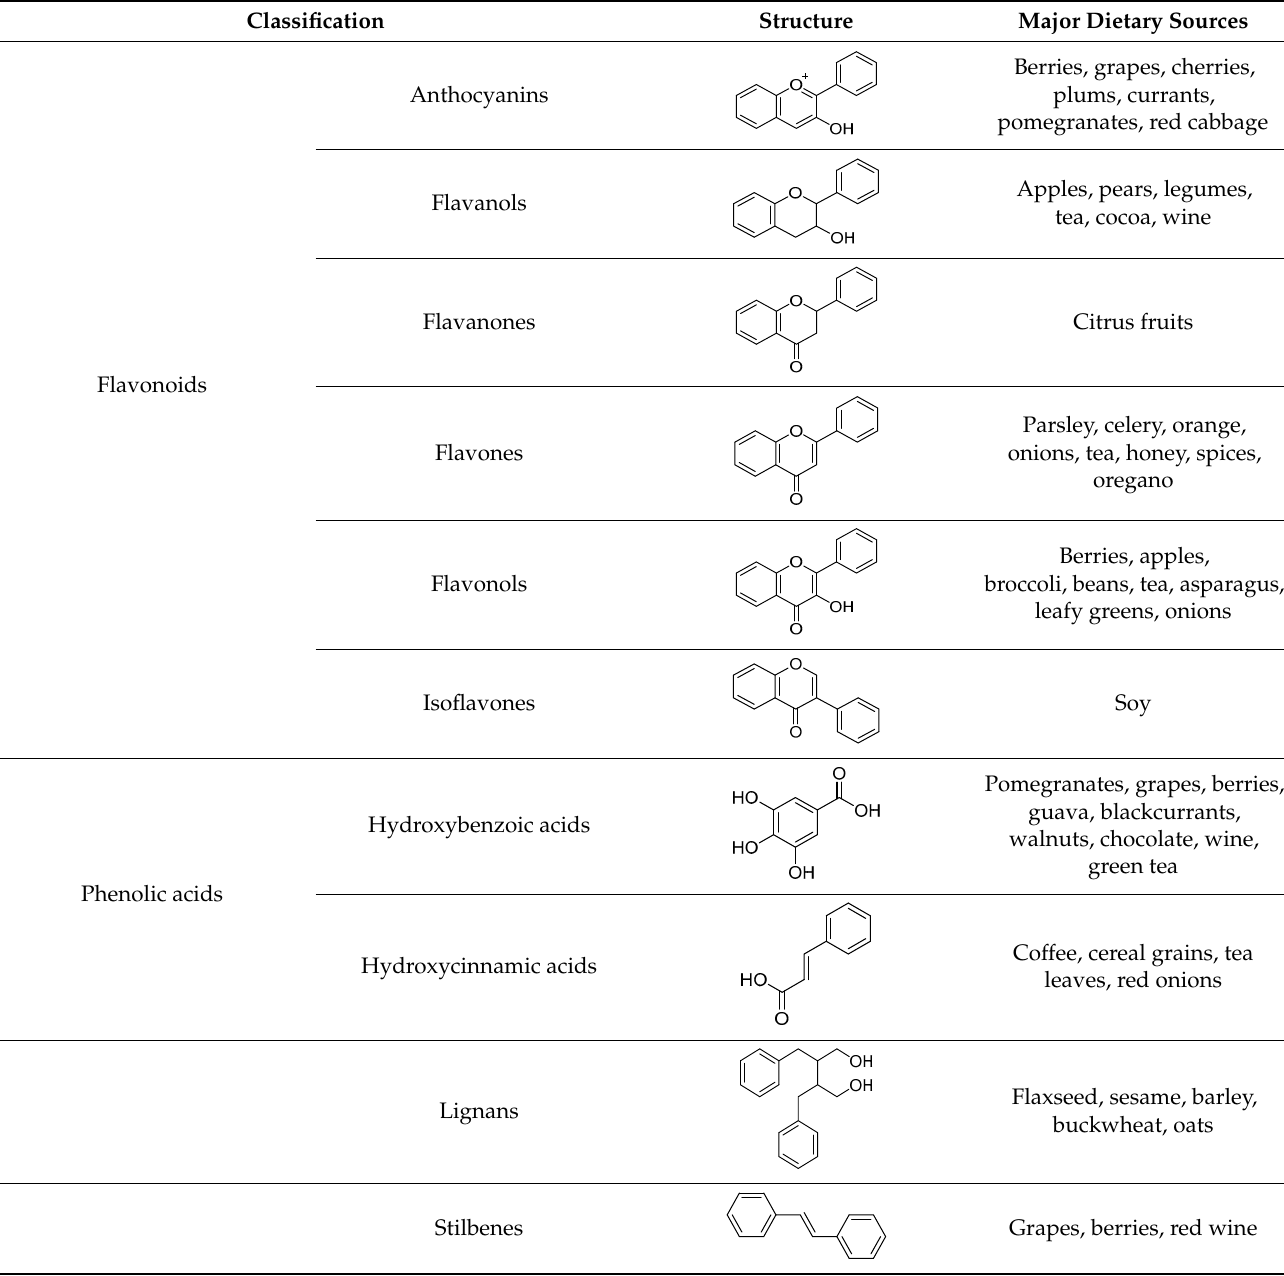
Table 2. Polyphenol and secondary metabolite classification and dietary sources.